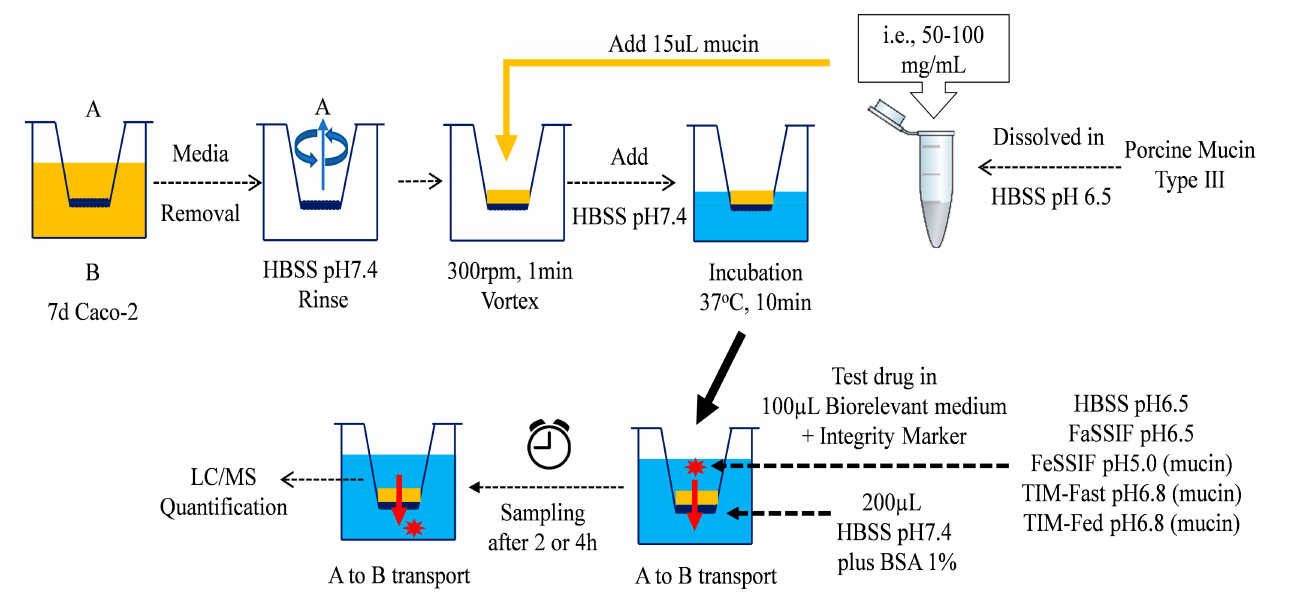
Figure 1. Applications of fasted- and fed-state biorelevant media as the apical (A) media systems in mucin-protected Caco-2 model for the assessment of drug permeability from the basolateral (B)